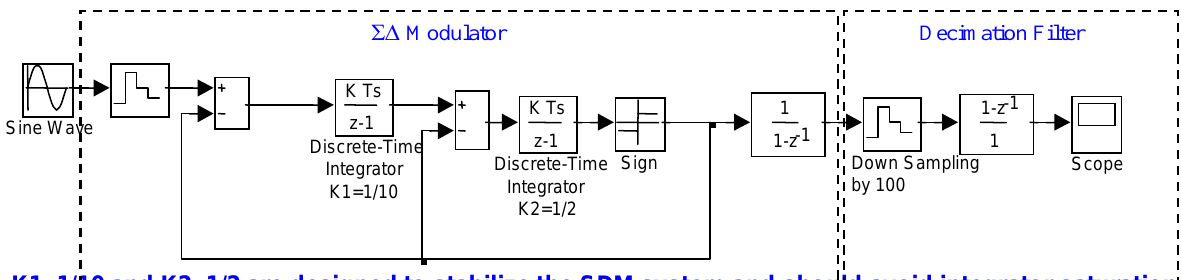
Figure 8. One-bit ΣΔ modulator circuit design.